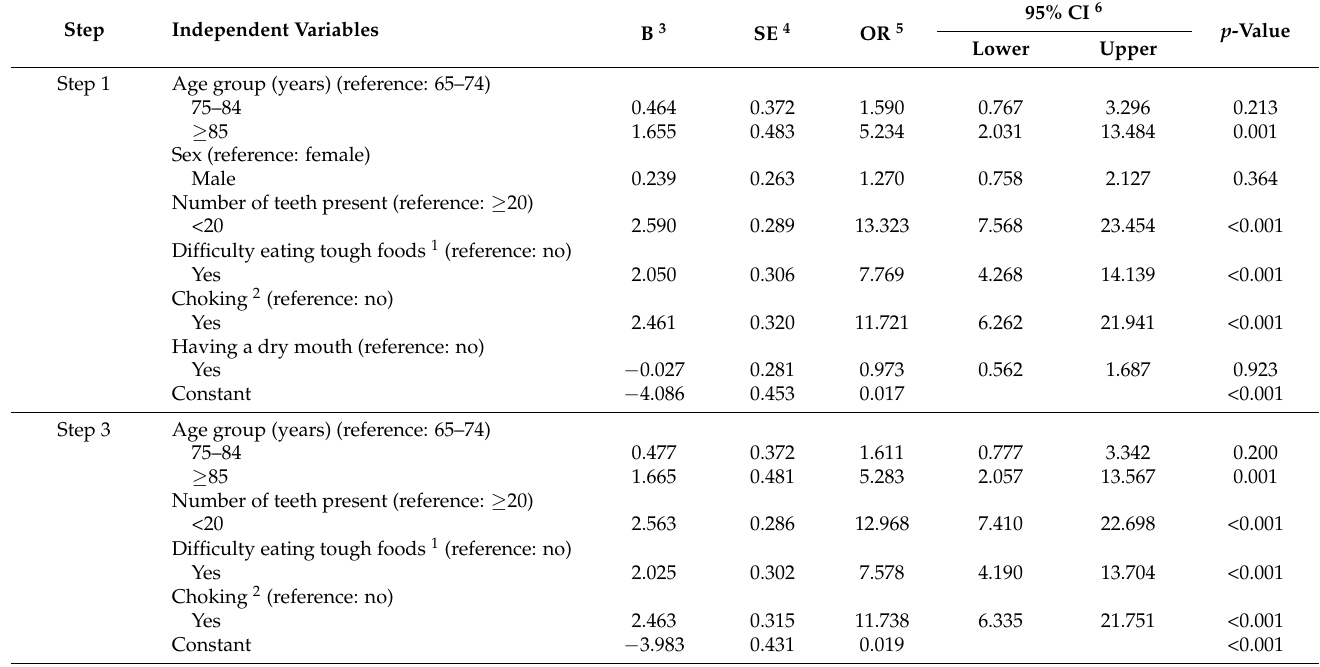
Table 3. Results of logistic regression analyses with stepwise variable selection for oral frailty in the training